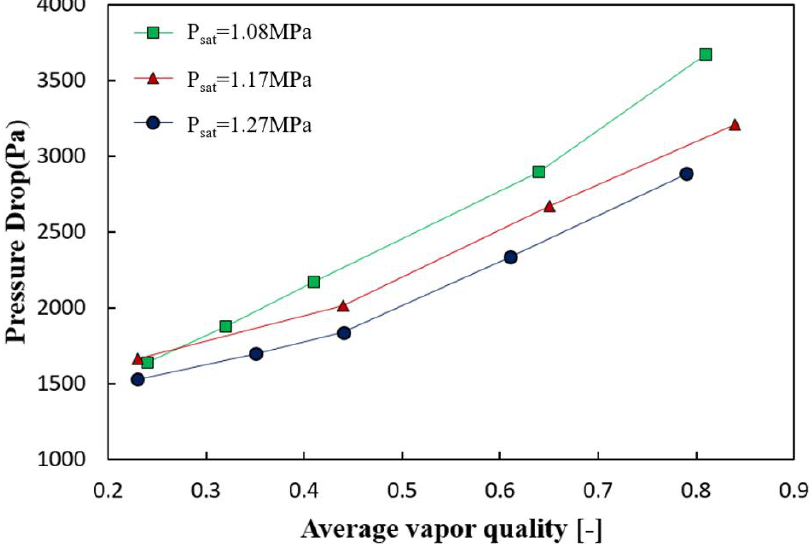
Figure 11. Pressure drop according to saturation pressure at various vapor quality condition.